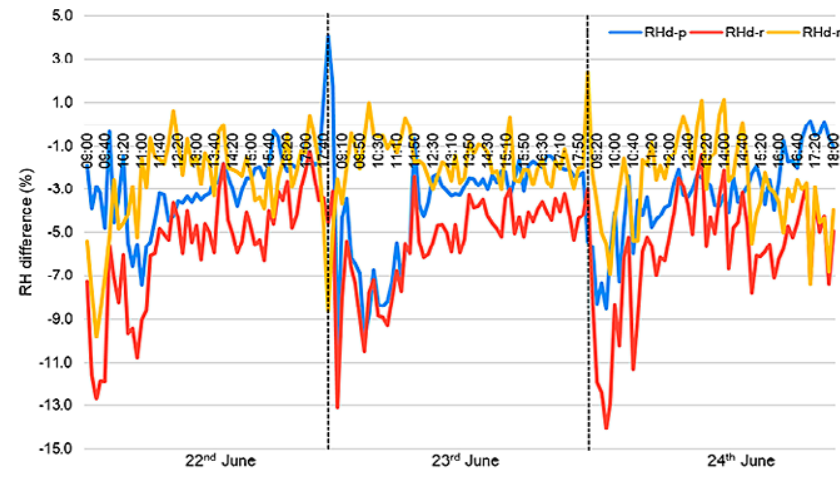
Figure 5. Temporal variation of RH in Banja Luka (Bosnia and Herzegovina) in the period 22-24 June 2021 (measurement period 9-18 h CEST). NOTE: RH represents relative humidity difference between downtown d-p and urban park; RH represents relative humidity difference between downtown and riverside; d-r and RH represents relative humidity difference between urban park and p-r